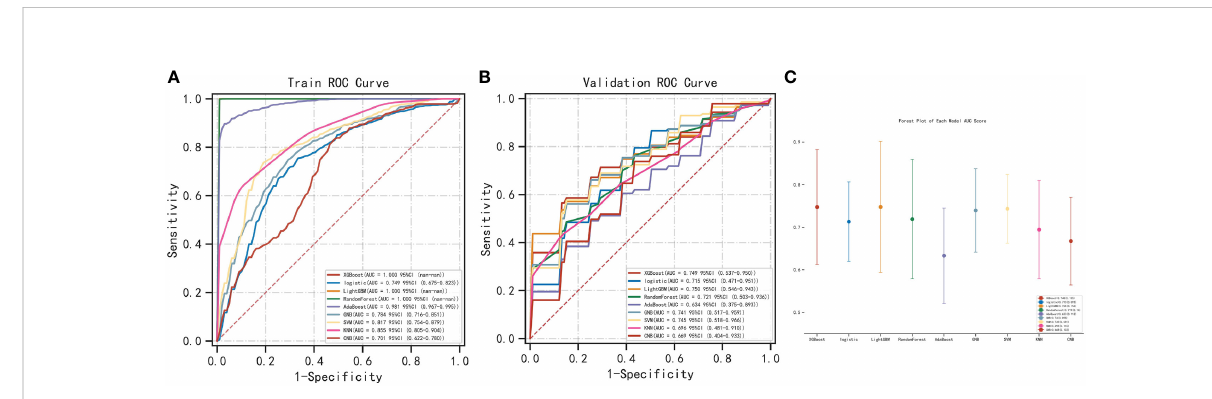
FIGURE 7 Construction of metastasis model. (A) REFCV method to fi lter out key metastatic variables in train set. (B) REFCV method to fi lter out key metastatic variables in validation set. (C) Multi-model forest